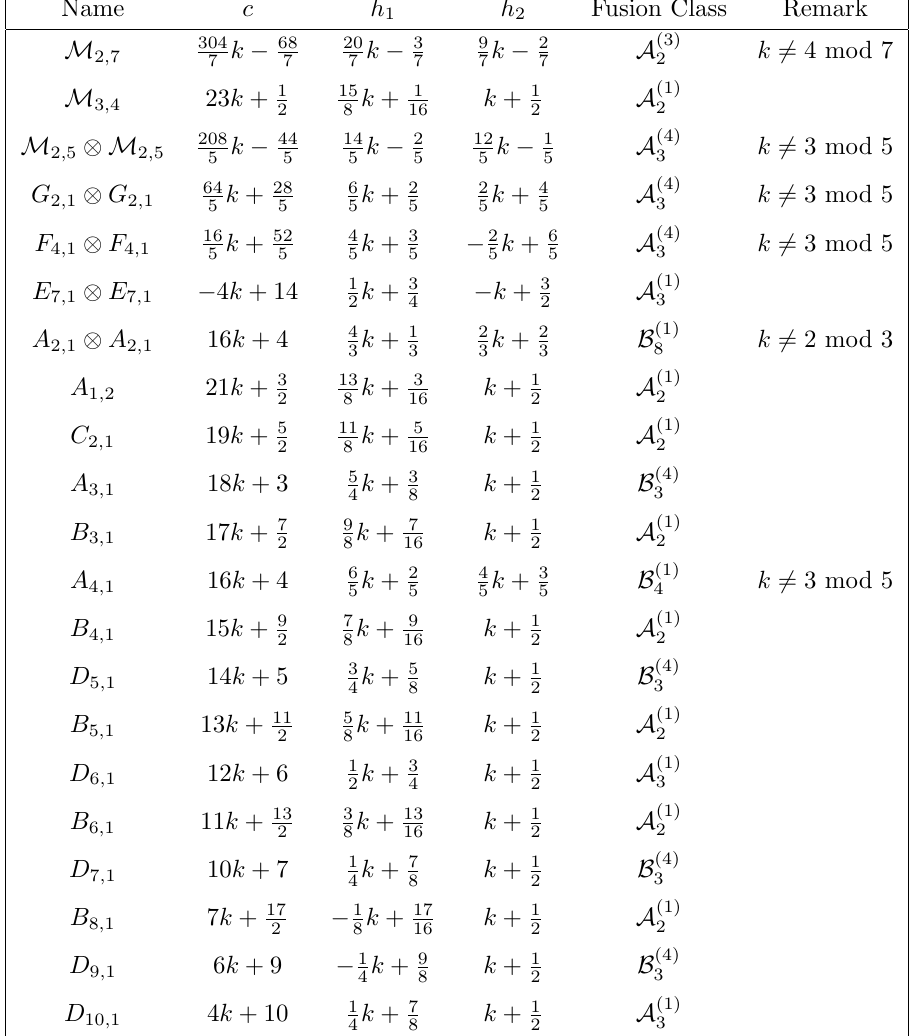
Table 1 . Quasi-character series from coset